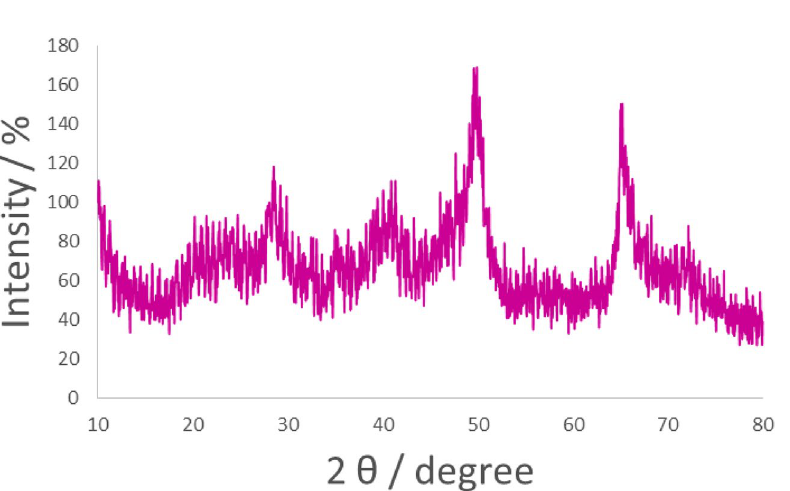
Figure 15. The powder XRD pattern of recovered Sm-bis(PYT)@boehmite.